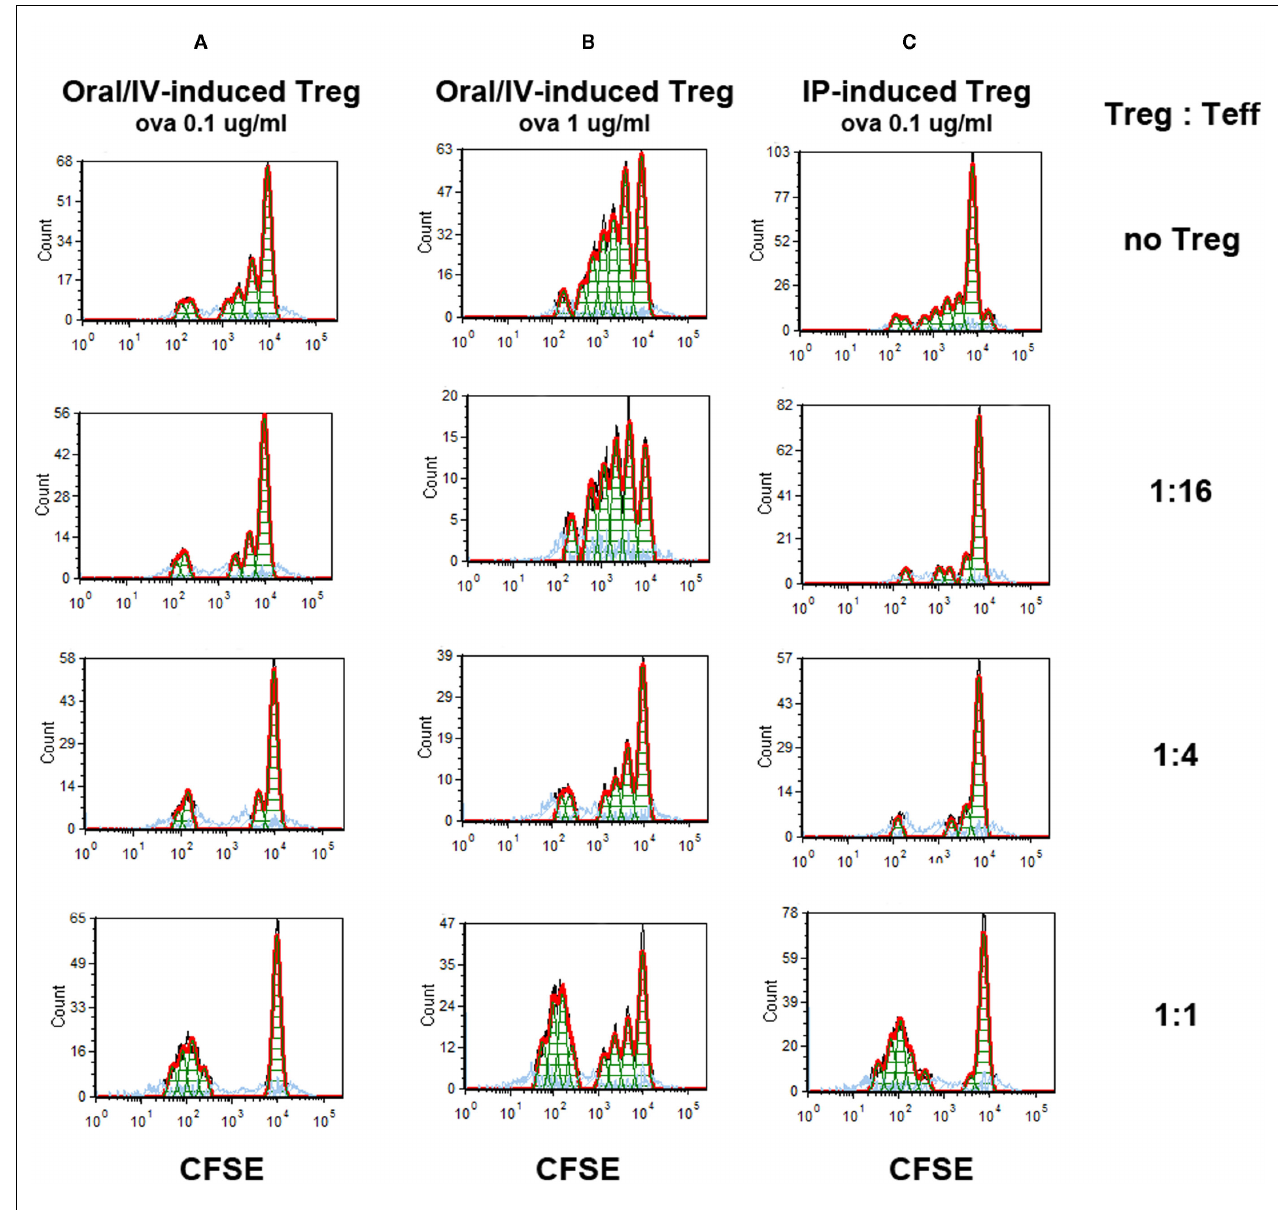
FIGURE 6 | Suppression of antigen-specificTeff proliferation by induced Treg. Treg induced by 4weeks of oral rapamycin/IV ova peptide-treated (A,B) or rapamycin/ova peptide IP-treated (C) DO11.10-tg Rag − / − BALB/c mice were co-cultured in the indicated ratios withTeff cells and APCs.Teff were